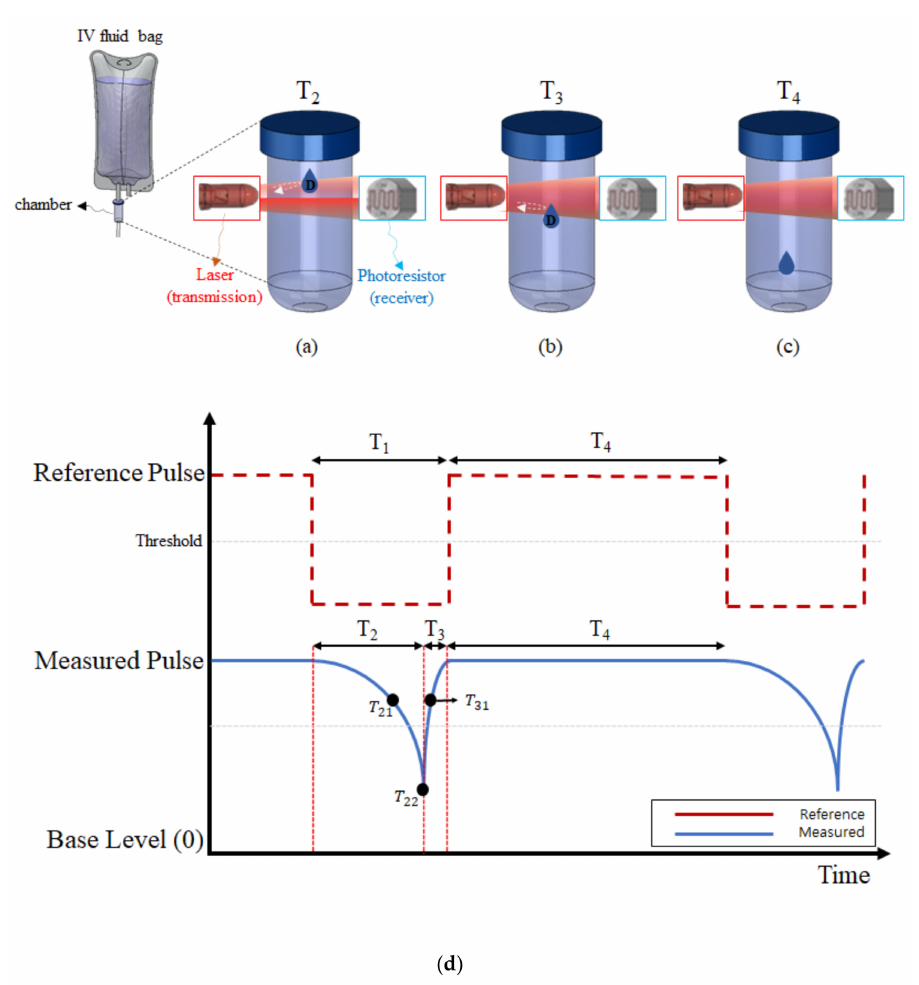
Figure 3. Working mechanism of the photosensors. ( a ) T 2 , ( b ) T 3 , and ( c ) T 4 of a chamber. ( d ) Graph describing the variation gap between the ideal and real